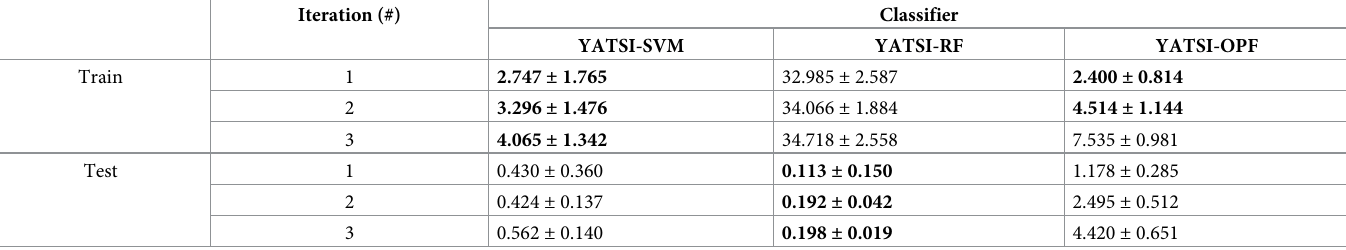
Table 3. Average computational times and standard deviations (in milliseconds) per iteration for the training and testing processes, using the semi-supervised clas- sifiers for the ALL-AML dataset. The best results (shorter times) are highlighted in